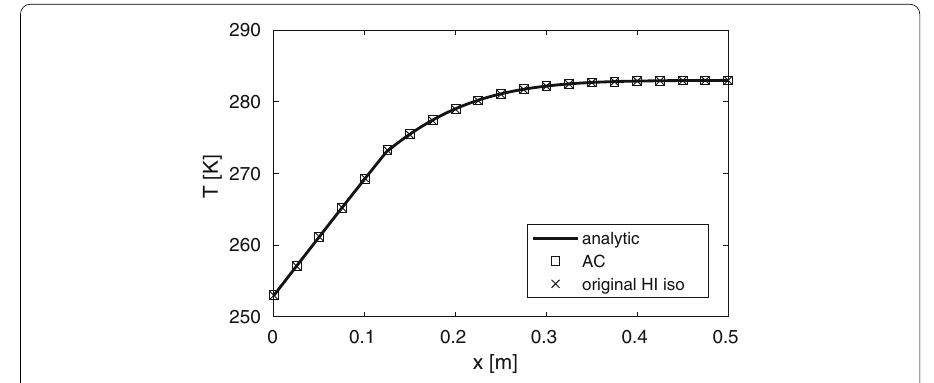
Fig. 6 Melting front example: temperature profiles at t f of analytic solution compared to numerical results with AC and HI method. 100 elements, (cid:11) t = 200s